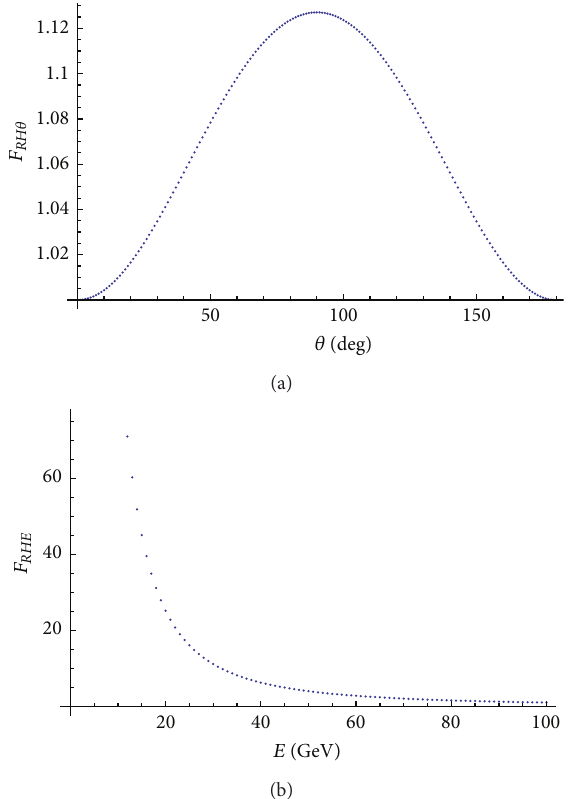
Figure 25: The variation of (a) 𝐹 𝑅𝐻𝜃 (𝐸,𝜃) , defined in the text with 𝜃 for 𝐸 = 1.5 GeV, (b) with 𝐸 for 𝜃 = 𝜋/4 for virtual heavy quarks (colour online). The results displayed in this figure are evaluated for heavy quark mass, 𝑚 = 1.27 GeV, and emitted gluon energy, 𝑘 0 = 20 MeV and 𝛽 = 0.5 . The quark virtuality is defined as 𝑉 2 = 𝐸 2 − 𝛽 2 𝐸 2 − 𝑚 2